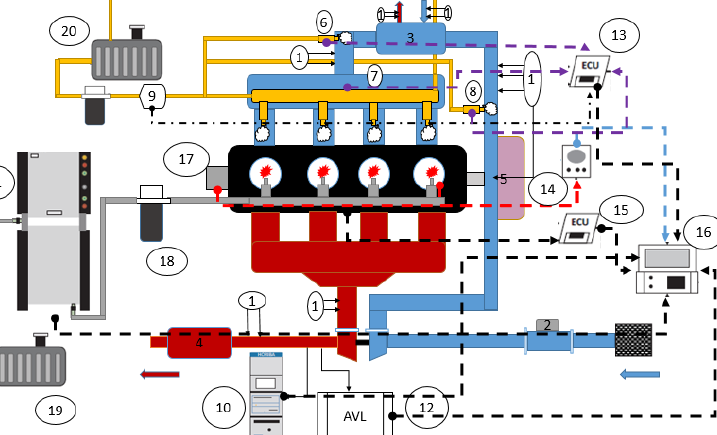
Figure 1. A schematic diagram of the engine test bench; (1) pressure/temperature sensor, (2) airflow meter, (3) intercooler, (4) silencer, (5) dynamometer, (6) intercooler injection point, (7) intake manifold injection point, (8) intercooler injection point, (9) methanol flow Meter, (10) MEXA-584L, (11) FCMM-3 fuel consumption measuring instrument, (12) AVL DISMOKE 4000, (13) methanol control unit, (14) KISTLER Charge Amplifier 5018, (15) diesel injection control unit, (16) computers, (17) HRC-F15-720 angle encoder, (18) filters, (19) diesel oil container, (20) methanol